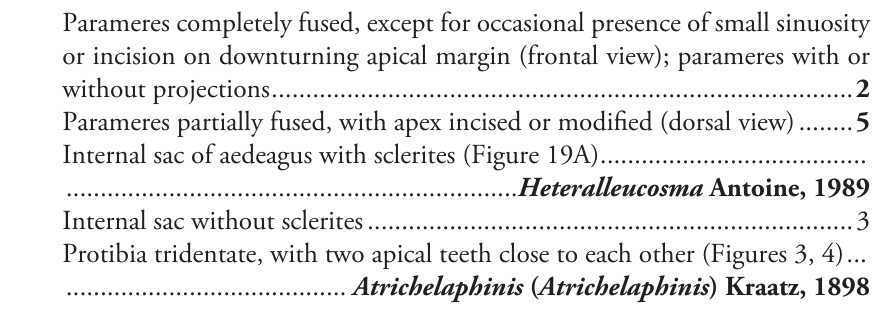
Key to the African genera of Cetoniini close to Atrichelaphinis , with completely or partially fused